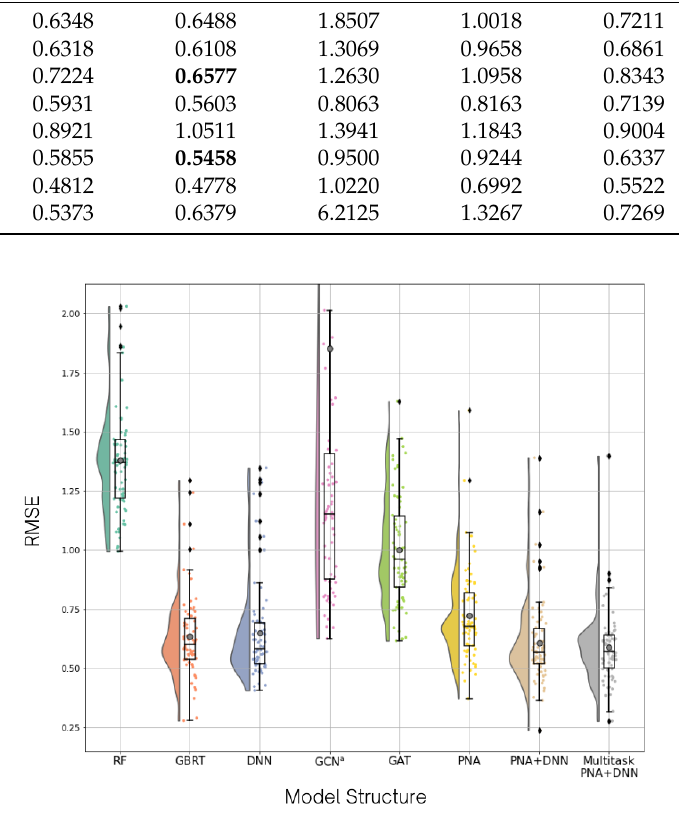
Figure 3. Benchmark model comparison. In this graph, each model structure consists of all RMSE values from 10-fold cross-validation for all targets. The RMSE distribution is shown in a half-violin plot and box plot, which shows quartiles 1, 2, and 3 of the distribution. The mean value of each model is marked as a grey dot inside the box plot. a Note that the graph does not cover all RMSE points in the GCN plot, this is due to an extensive spread of the outlier data in the RMSE range of 6.5–8.5. The GBRT model shows the lowest overall RMSE among the descriptor-based bench- mark models (RF, GBRT, and DNN) with the average overall RMSE of 0.6348. However,